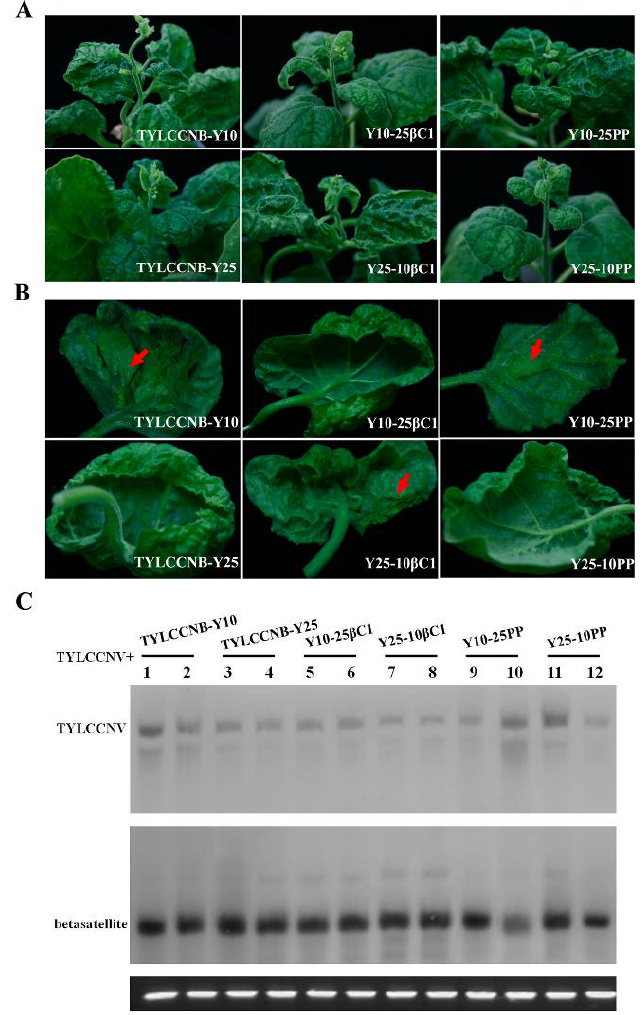
Figure 5. Symptoms induced by co-inoculation with TYLCCNV and either wild-type or hybrid satellites of TYLCCNB-Y10 and TYLCCNB-Y25 in N. benthamiana . ( A ) Whole plants. Photographs of plants were taken at 30 dpi; ( B ) abaxial surfaces of leaves. Arrowheads indicate enations; ( C ) Southern blot analysis for viral DNA in N. benthamiana plants. The blots were probed either for TYLCCNV (top) or for betasatellite (bottom). The lower panel represents an ethidium bromide-stained gel of DNA samples as a loading control.